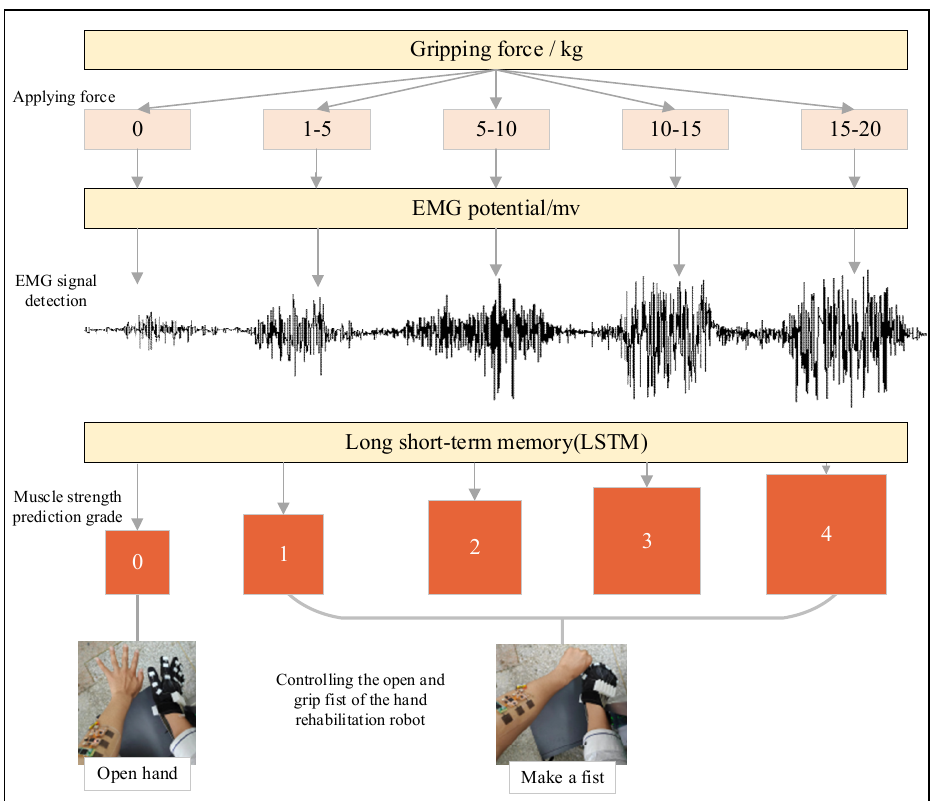
Figure 8. Flow chart of grip force prediction algorithm and hand rehabilitation control method.